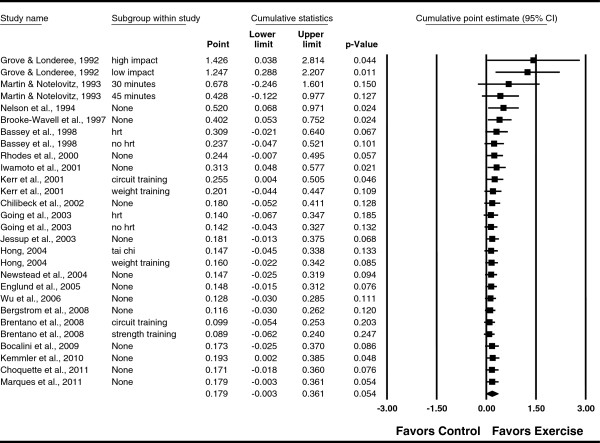
Cumulative meta-analysis for changes in LS BMD. Cumulative meta-analysis, ordered by year, for point estimate standardized effect size changes (g) in LS BMD. The black squares represent the standardized mean difference (g) while the left and right extremes of the squares represent the corresponding 95% confidence intervals. The results of each corresponding study are pooled with all studies preceding it. The middle of the black diamond represents the overall standardized mean difference (g) while the left and right extremes of the diamond represent the corresponding 95% confidence intervals. For subgroup, HRT means hormone replacement therapy.